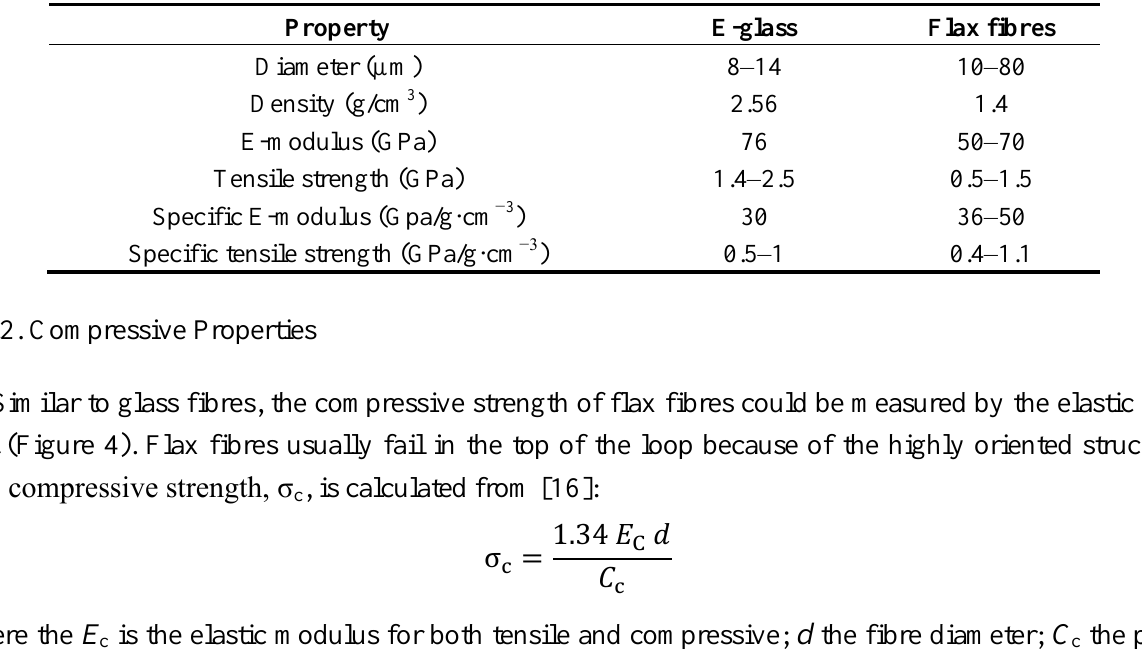
Table 3. Tensile properties of glass and flax fibres [16].